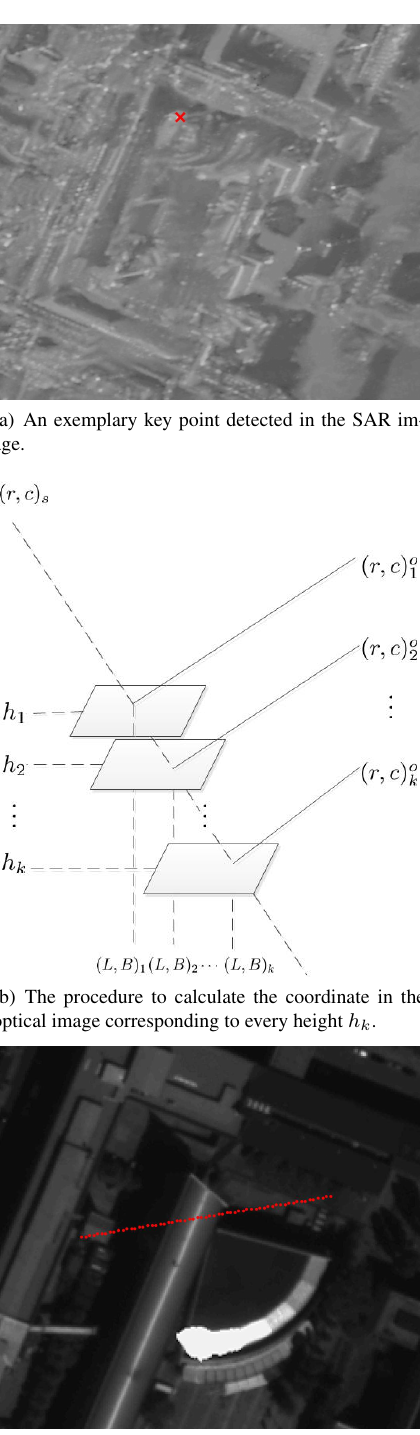
Figure 2. Exemplary illustration of the procedure for construction of the IMBLS search